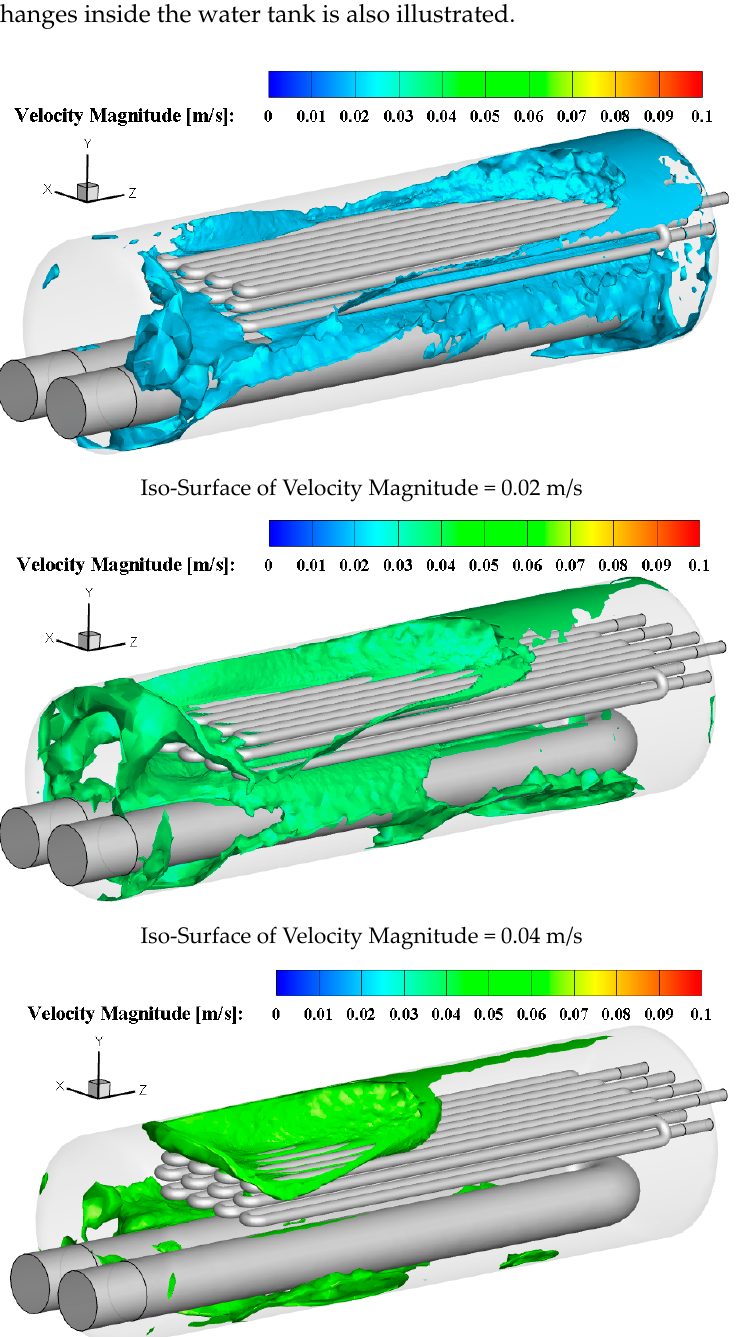
Figure 16. The streamline with the contour of velocity magnitude inside the water tank of the heater under